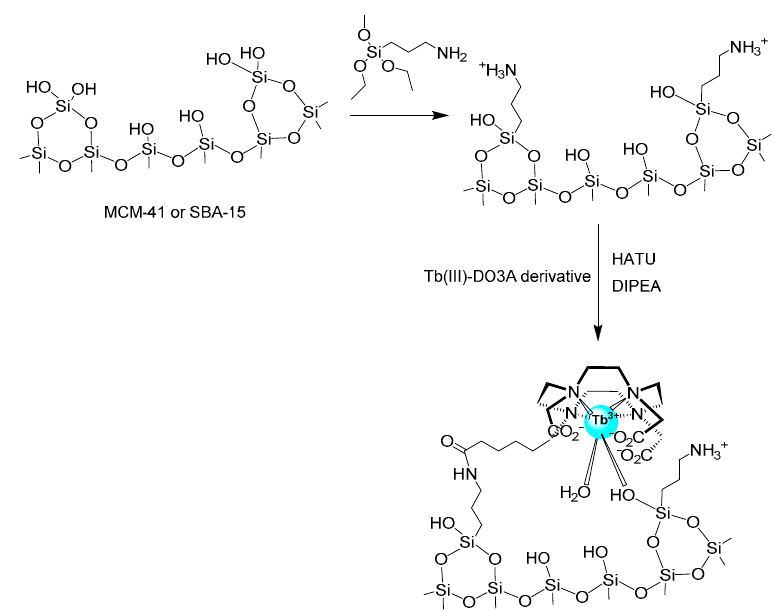
Scheme 1. Schematic view of the functionalization of silica surface with amino groups and Tb(III)-DO3A derivative complex. Magnetochemistry 2020 , 6 , x FOR PEER REVIEW